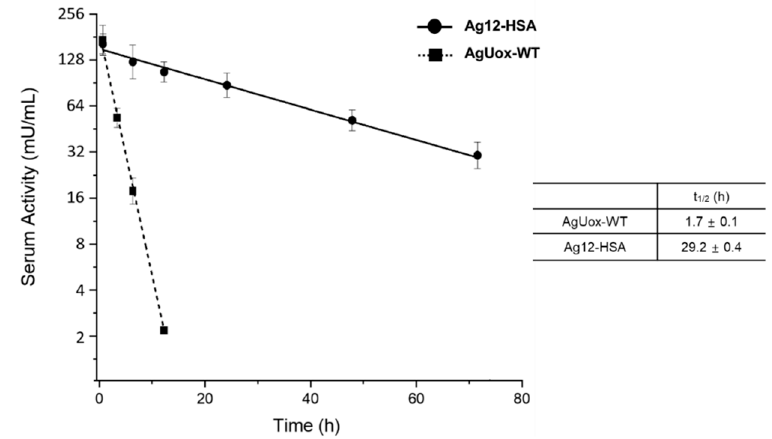
Figure 8. Pharmacokinetic studies of AgUox-WT and Ag12-HSA in mice. Enzymatic activity of residual AgUox-WT and Ag12-HSA conjugate samples was measured at 15 min; at 3, 6, and 12 h for AgUox-WT; and 15 min and 12, 24, 48, and 72 h for Ag12-HSA. The samples for pharmacokinetic studies were intravenously injected into BALB/c female mice ( n = 4). Error bars indicate the standard deviation.